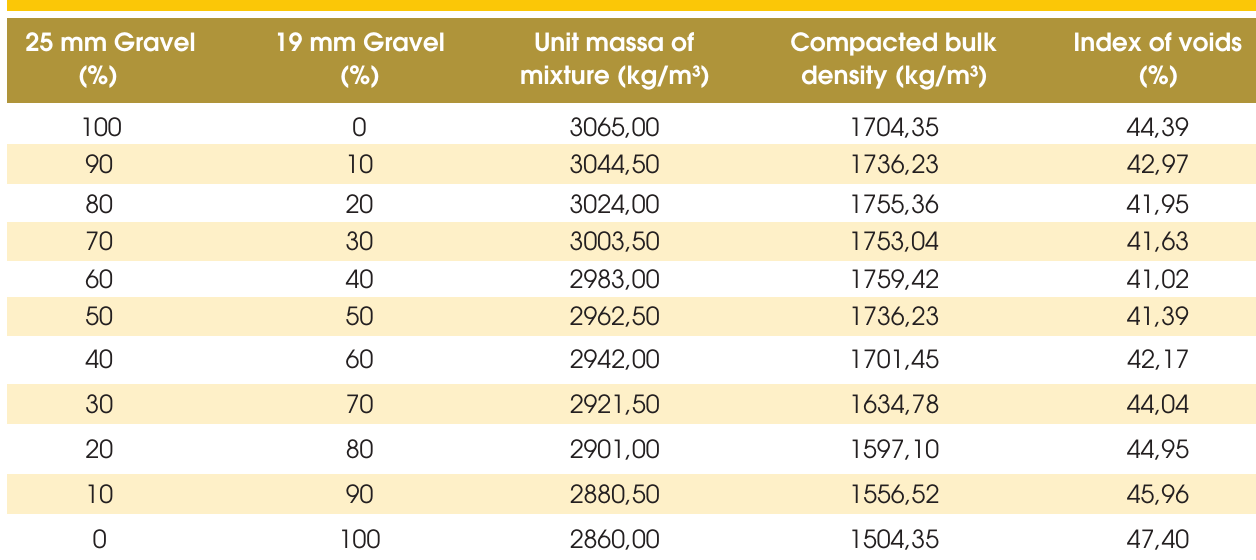
Table 2 – packing test between 25 mm gravel and 19 mm